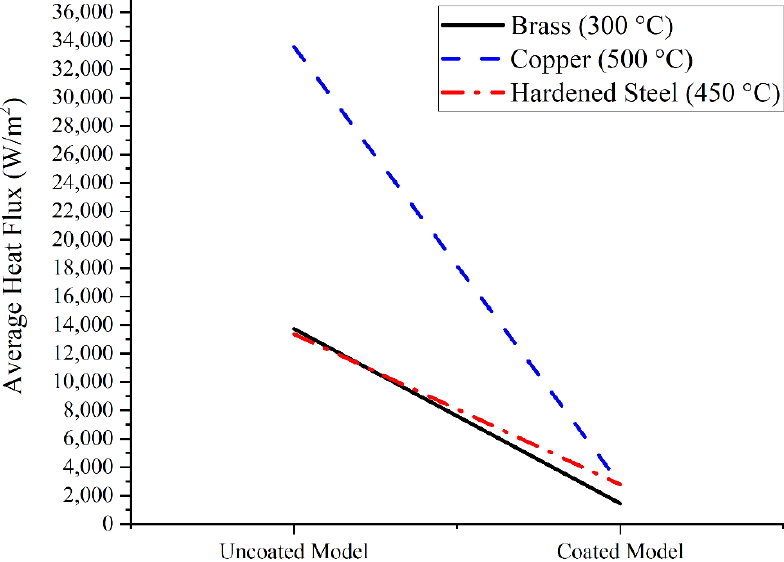
Figure 7. The average heat flux of the coated and uncoated models.